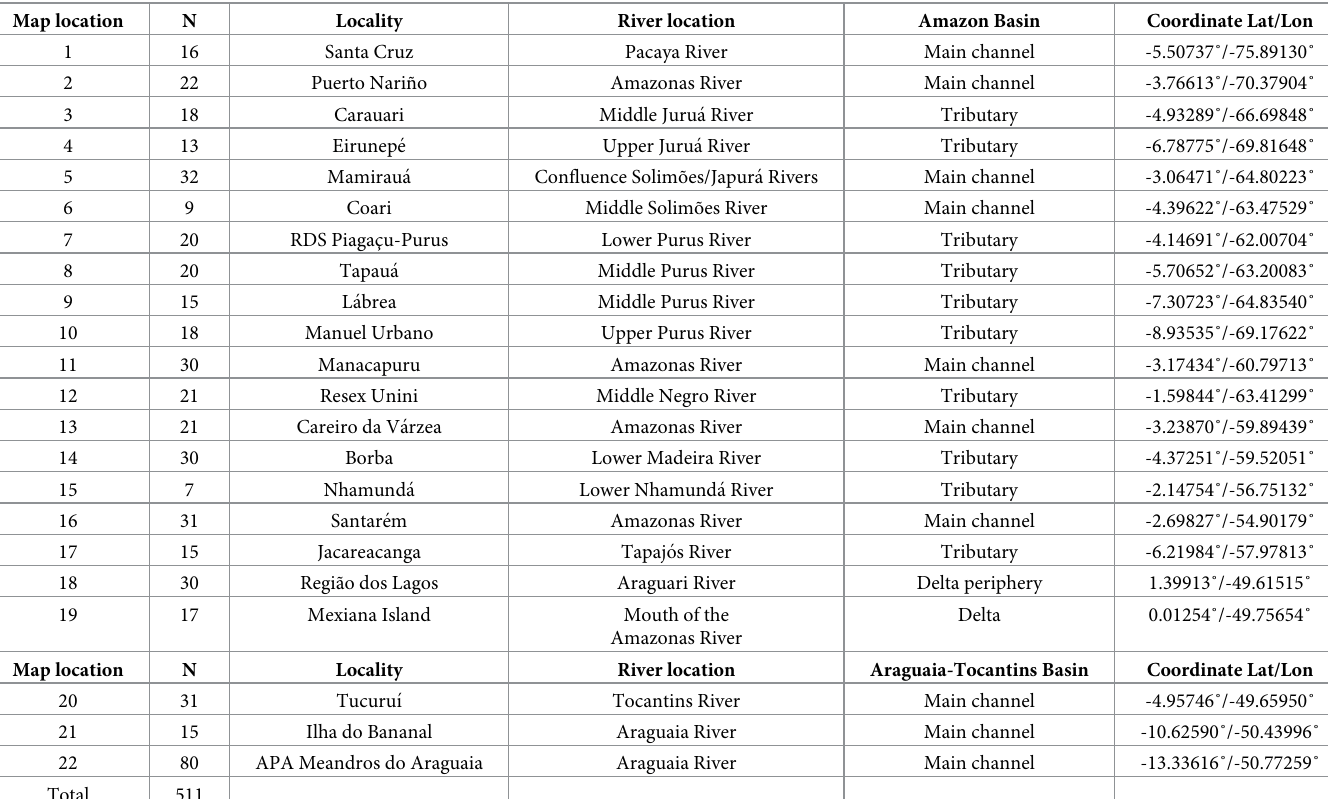
Table 1. Sampling areas of Arapaima gigas analyzed in the present